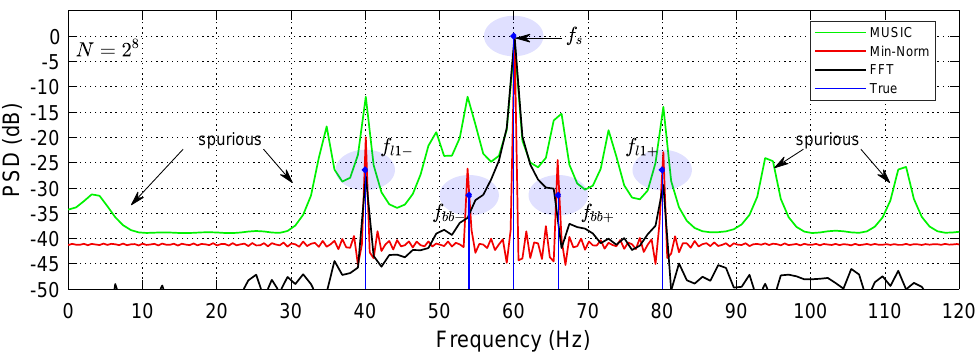
Figure 1. Comparison of spectra obtained from simulated data (IM stator current in white noise data record length of N = 256), using: FFT, MUSIC, Min-Norm, and the true